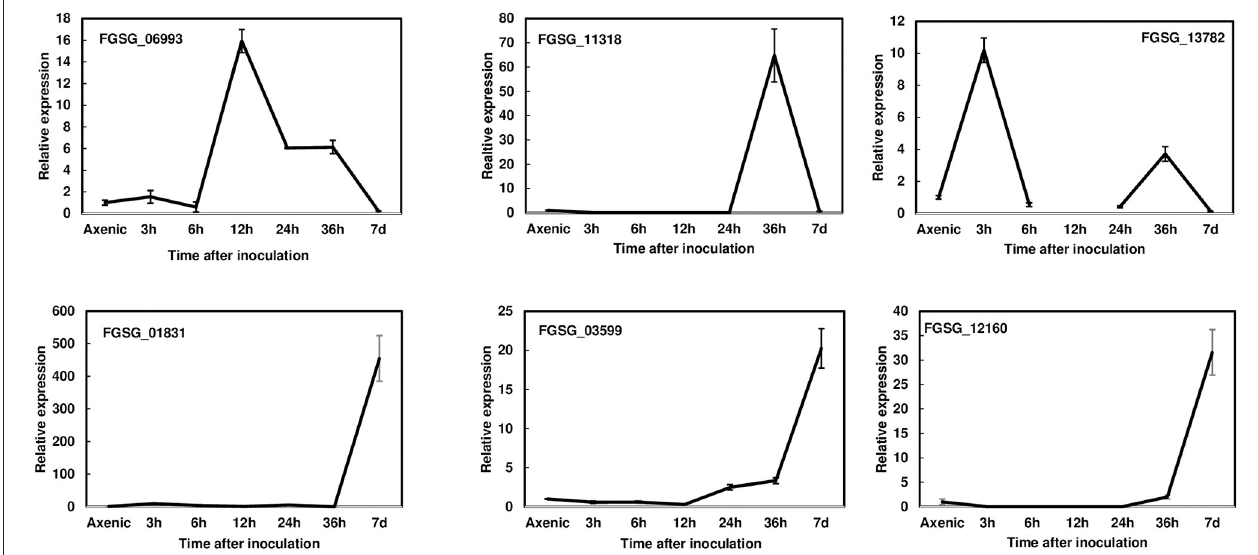
FIGURE 1 | Gene expression profiles of selected effectors upregulated during wheat head infection. Wheat heads were collected at 3, 6, 12, 24, 36 hpi, and 7dpi after whole-head dip inoculation. Three biological replicates, each replicate containing two heads, were collected at each time point and used for RNA isolation and cDNA synthesis. Fungal β -tubulin was used as an internal control for transcript normalization. Fold changes of gene expression were relative to axenic culture, which was grown on V8 plates for 7 days. Three technical replicates were used for each